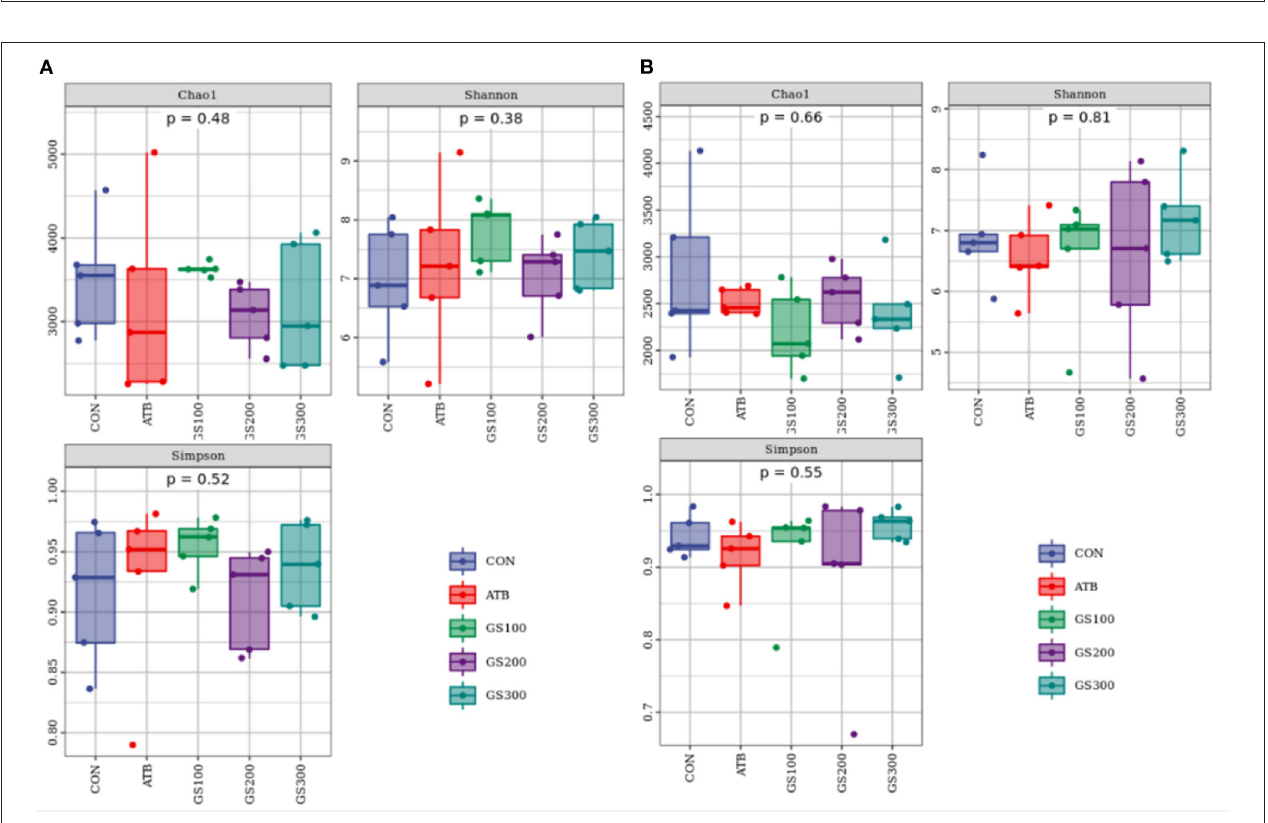
FIGURE 6 | Effects of Ginsenoside Rg1 on the alpha diversity of intestinal microbiota at day 29 (A) and day 52 (B) in broiler chickens ( n = 5). CON, birds fed a basal diet; GS100, birds fed a basal diet supplemented with 100 mg/kg ginsenoside Rg1; GS200, birds fed a basal diet supplemented with 200 mg/kg ginsenoside Rg1; GS300, birds fed a basal diet supplemented with 300 mg/kg ginsenoside Rg1; ATB, a basal diet supplemented with 300 mg/kg chlortetracycline.